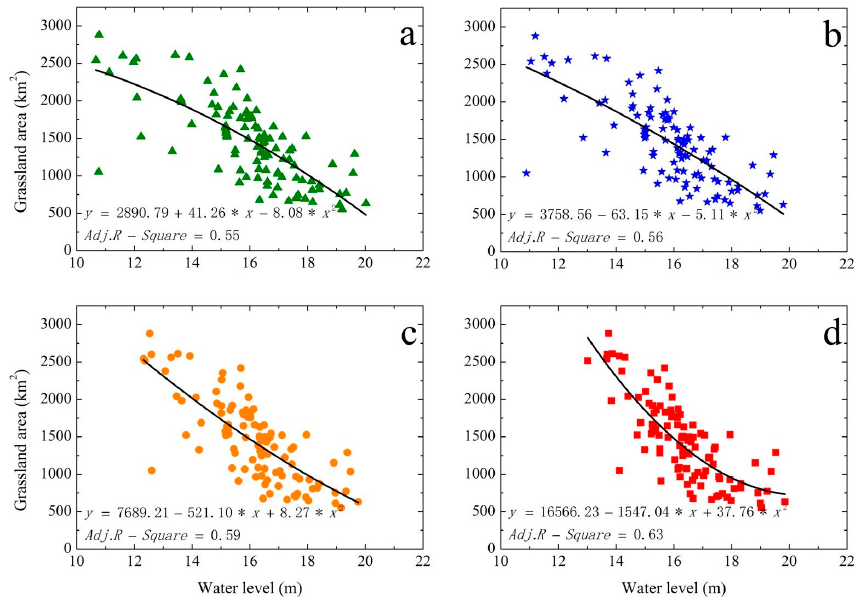
Figure 5. Relationships between grassland area and water level fluctuations (( a ) Xingzi; ( b ) Duchang; ( c ) Tangyin; ( d ) Kangshan) during the flood period.